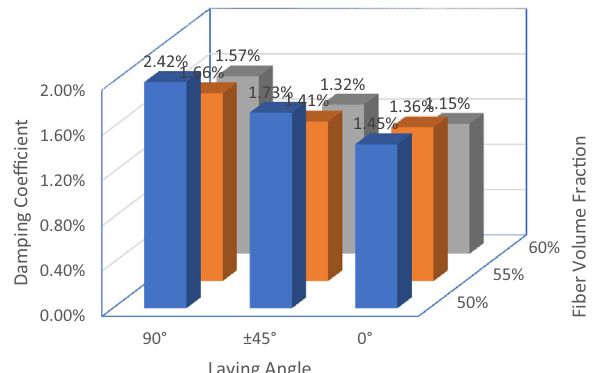
Figure 7. Comparison chart of damping coefficient.